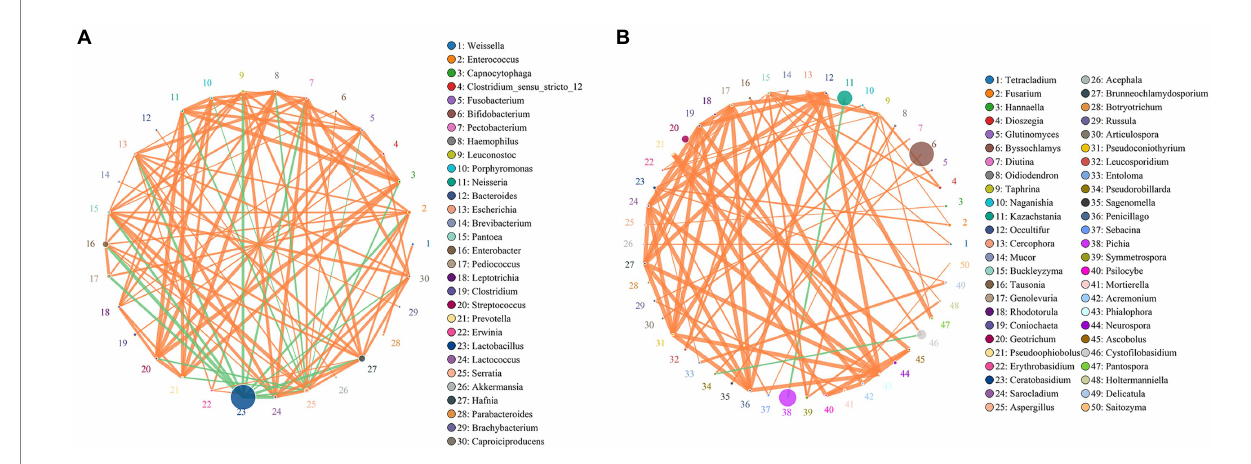
FIGURE 5 Taxa–taxa interactions at the species level in (A) bacterial and (B) fungal co-occurrence networks using Spearman’s rank correlation analysis set at a permutation value of 200, correlation >0.6 and p -value <0.05. Circles represents species and size of circle represents abundance. The edges represent the correlation between the two species. The thickness of the edge represents the strength of the correlation. The orange line represents a positive correlation and the green line represents a negative